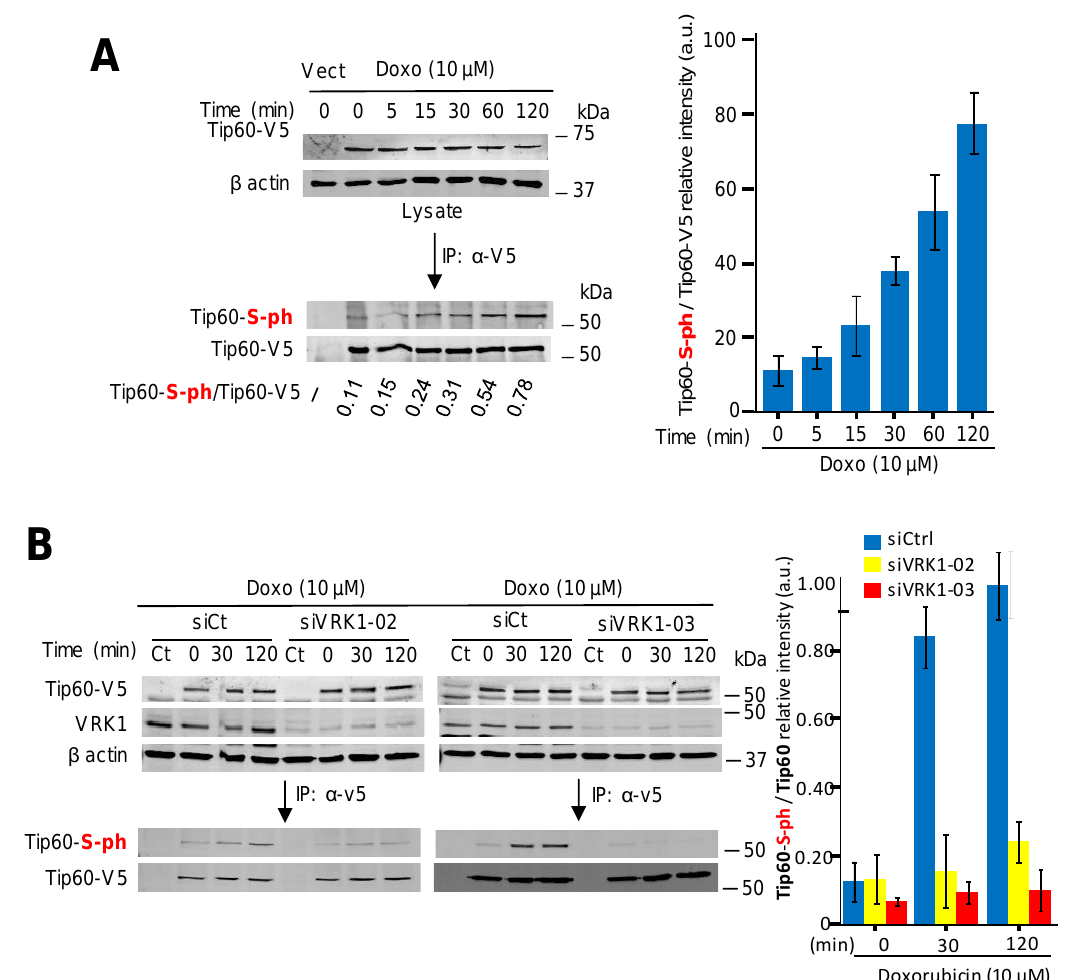
Figure 6. The phosphorylation of Tip60 is independent of ATM and lost by VRK1 depletion. ( A ). Time course of the phosphorylation of Tip60 by DNA damage induced by doxorubicin in HT144 cells ( ATM − / − ) deprived of serum (0.5% FBS) for 48 h before treatment. Tip60 was immunoprecipitated and its phosphorylation determined in Western blots. In the graph to the right is shown the relative increase in Tip60 phosphorylation from three independent experiments. Ct is a negative control of the transfection with an empty vector. ( B ). Depletion of VRK1 with two different siRNA causes a loss of Tip60 phosphorylation induced by doxorubicin in HT144 cells ( ATM − / − ). To the right is shown the quantification of the relative phosphorylation in siControl and siVRK1 in HT144 cells ( ATM − / − ). The graph to the right shows the relative increase in Tip60 phosphorylation from three independent experiments. Ct: Cells transfected with empty vector.